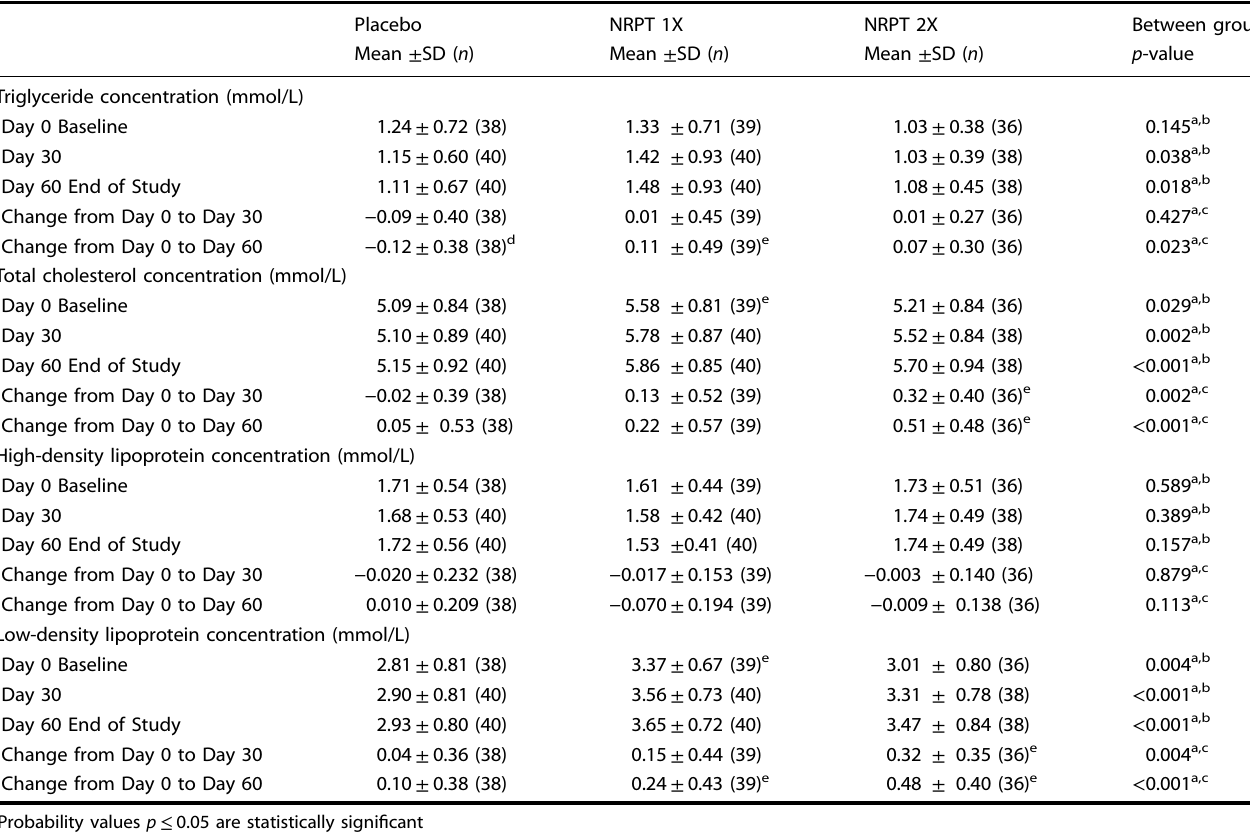
Table 3. Lipid pro fi le of participants at baseline (Day 0), day 30, and day 60 in the ITT population ( N = 118) Placebo